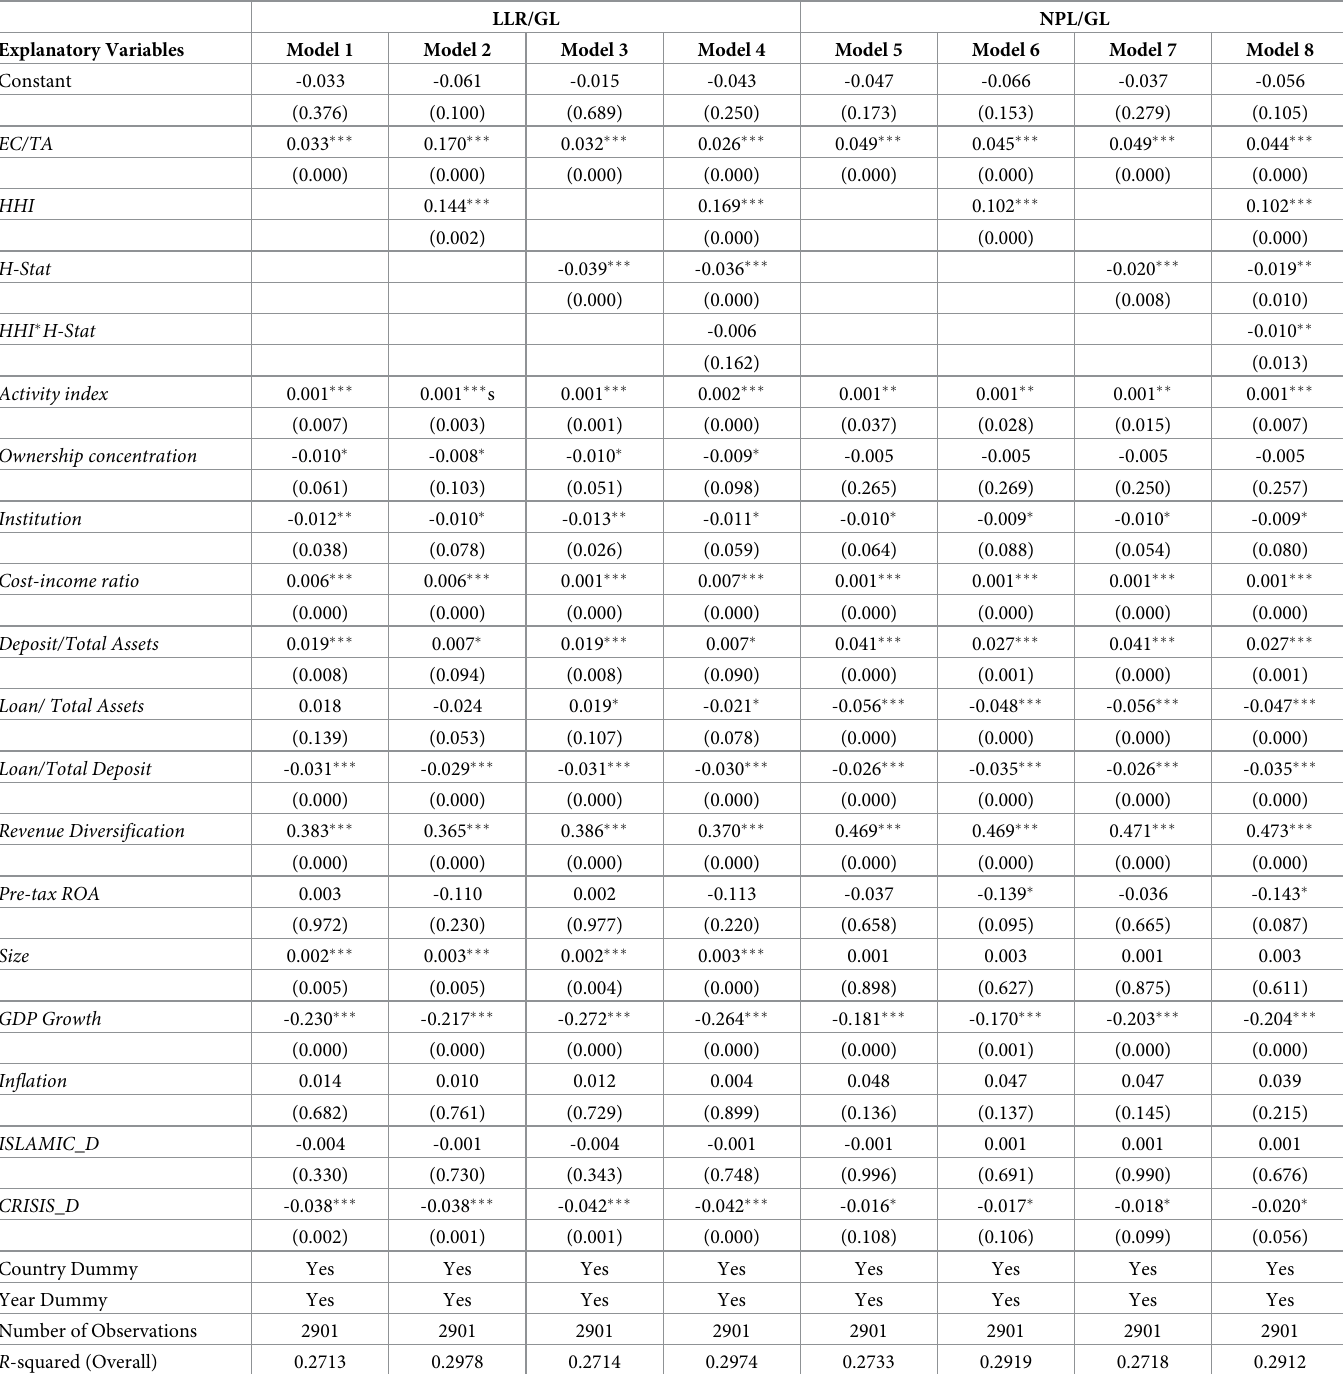
Table 6. Panel regressions of competition and credit risk (all banks,